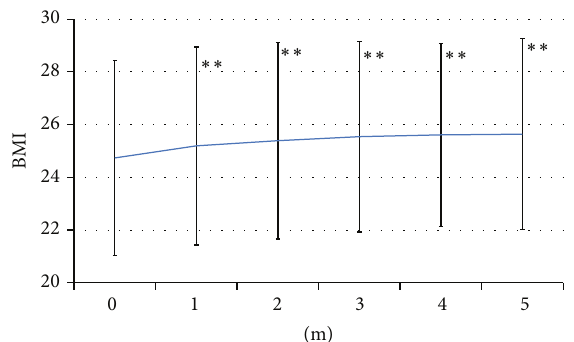
Figure 3: Changes of body mass index. Weight gain was not from 1 month after switching therapy. ∗∗ 𝑃 < 0.01